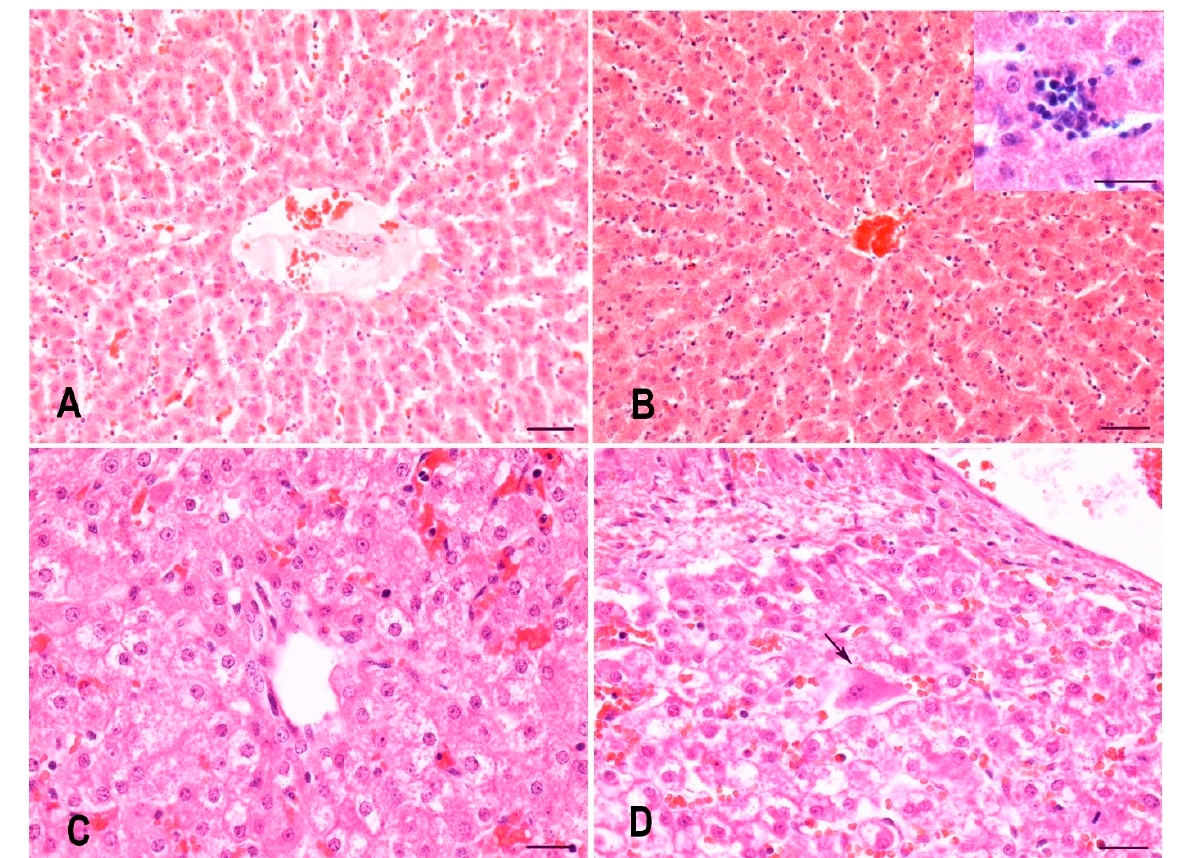
Figure 1. Representative microphotographs of the liver of gilts and their piglets: ( A ) gilt from the control group, ( B ) gilt from the experimental group with increased sinusoidal leukocytosis with inflammatory infiltrates of hepatic lobules (inset depicting the latter), ( C ) piglet from the control group with hepatocytes diffusely exhibiting vacuolar or granular cytoplasm, ( D ) piglet from the experimental group with hepatocytes diffusely exhibiting vacuolar or granular cytoplasm and a single hepatocyte exhibiting megalocytosis and megakaryosis (arrow). H&E, bar = 50 µm.